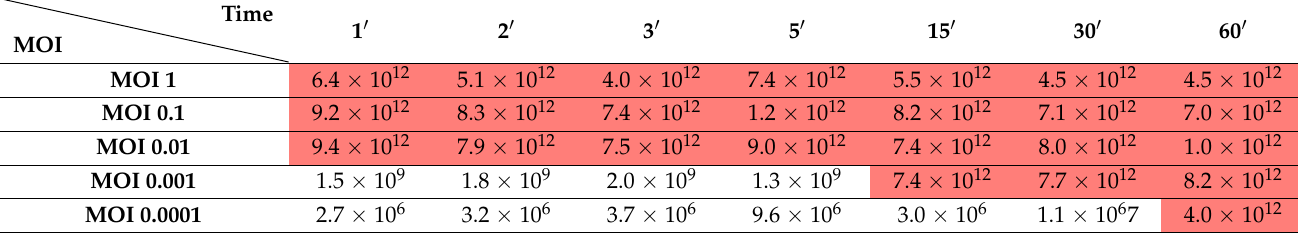
Table 1. The viral load at the 7th day post-infection at the different MOI (multiplicity of infection, 1, 0.1, 0.01, 0.001, 0.0001) and timing tested (1, 2, 3, 5, 15, 30, 60 min). The average viral load for mL of 6 replicates is reported. In red are depicted the conditions where an established infection was